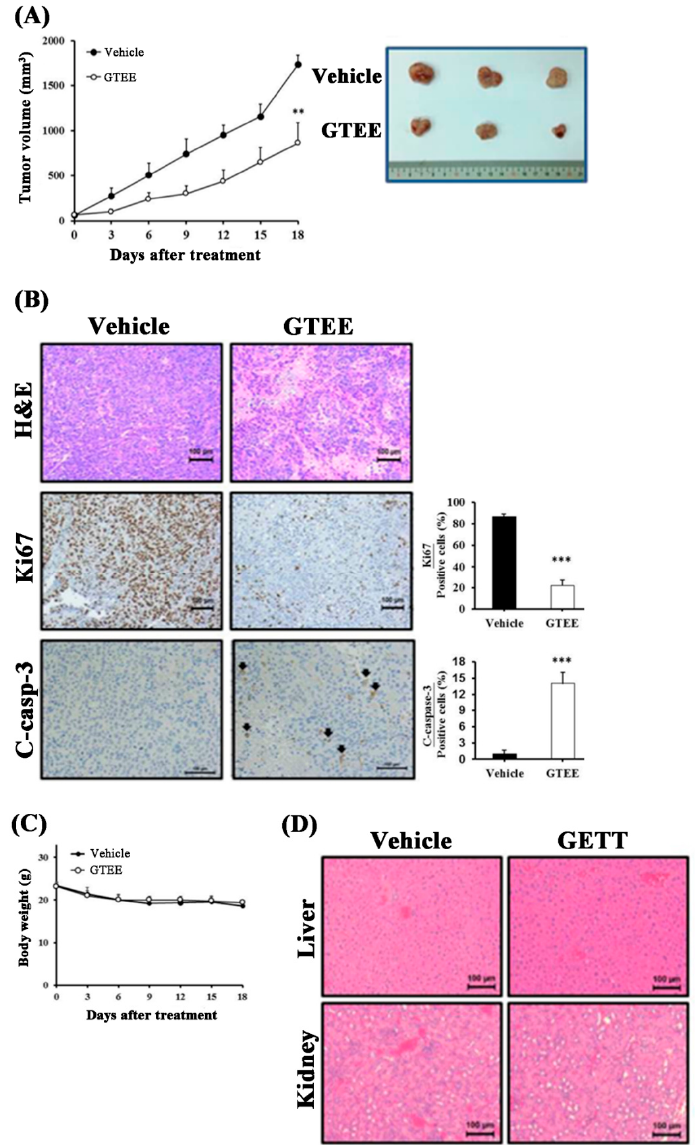
Figure 5. GTEE inhibits PC-3 tumor growth in a subcutaneous xenograft mouse model. ( A ) GTEE significantly inhibits the growth of subcutaneous PC-3 tumors compared to the control of vehicle-treated tumors for 18-day treatment. The tumor volumes (mm 3 ) represent as the mean ± SEM ( N = 5 / group). ** p < 0.01, significant di ff erences from the vehicle group. A Photograph of representative tumors in each group (Day 18) was shown (right bottom panel). ( B ) IHC staining results demonstrated that significant decrease of Ki67 (cell proliferation) and increase of cleaved ( C )-caspase-3 (apoptosis) were observed in the GTEE-treated PC-3 tumors compared to the control tumors. Scale bar = 100 µ m. Quantifications of Ki67 and C-caspase-3 were determined by counting positive stained cells in an average of five random fields. *** p < 0.001. ( C ) Body weights of the vehicle- and GTEE-treated mice during 18-day treatment were recorded. ( D ) H&E staining of liver and kidney harvested from the vehicle- and GTEE-treated PC-3 tumor-bearing mice. No obvious histopathological di ff erences were observed between these two groups in these organs. Scale bar = 100 µ